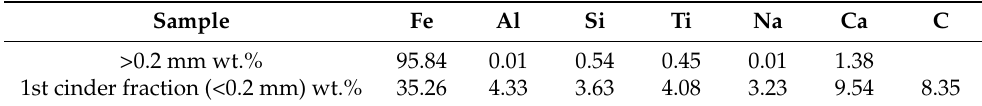
Table 5. Chemical analysis of the metallic iron spheres fraction with a particle size >0.2 mm and 1st cinder fraction with a particle size lower than 0.2